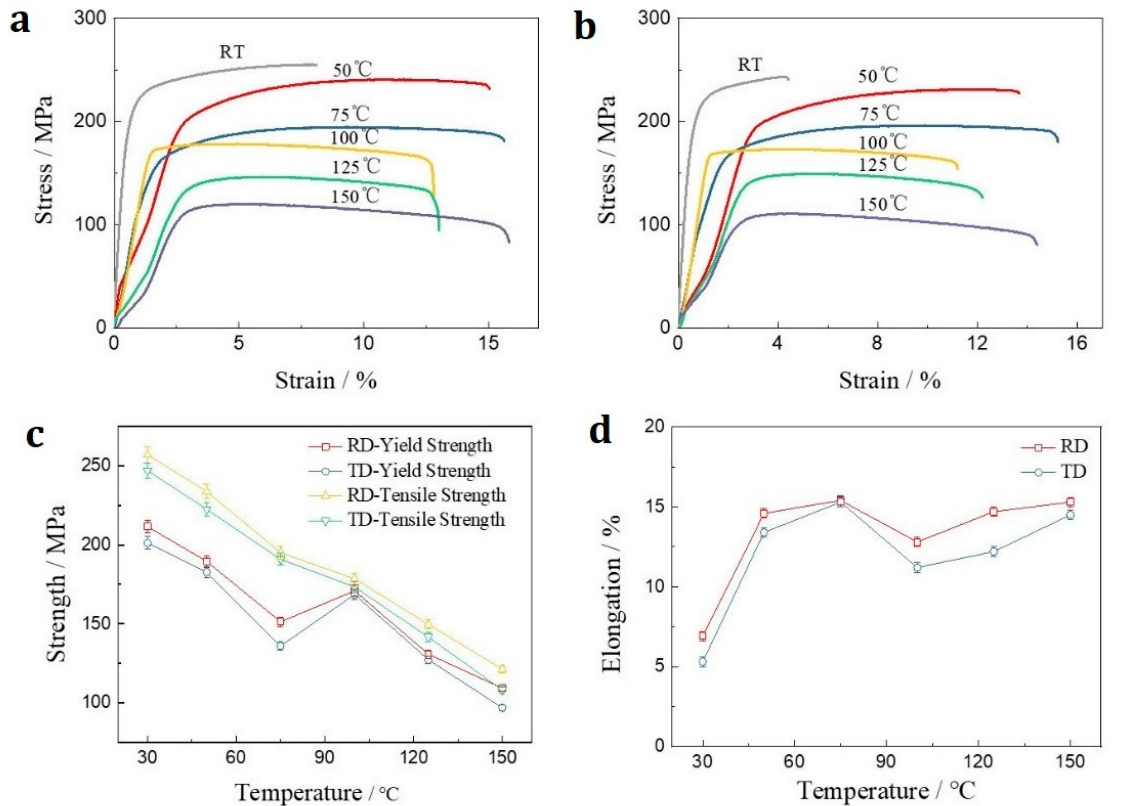
Figure 4. Tensile behaviors at elevated temperatures. ( a , b ) are the engineering stress–strain curves measured from the sample with force loading along RD and TD, respectively. ( c , d ) respectively demonstrate the evolution of yield strength, tensile strength and elongation with temperature ex- tracted from ( a , b ). Table 1. Summary of the mechanical properties of the MA21 sample at different temperatures. Temperature/ ◦